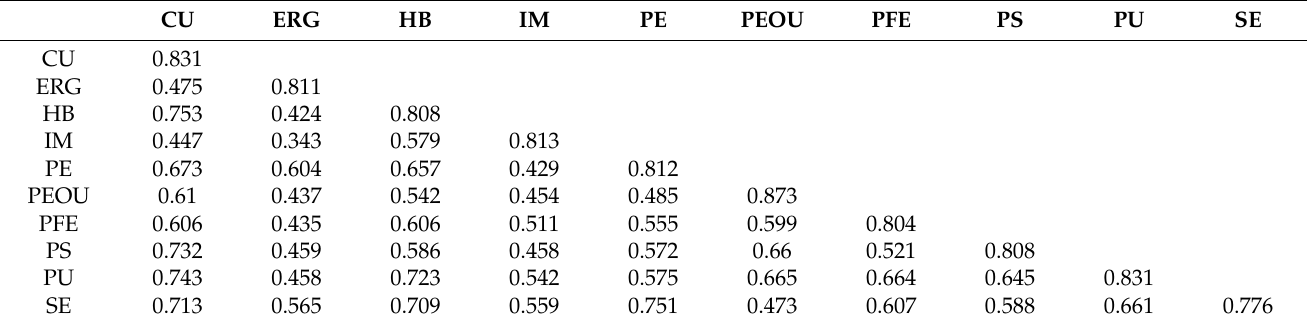
Table 3. Fornell-Larcker standard study for investigating discriminant validity.